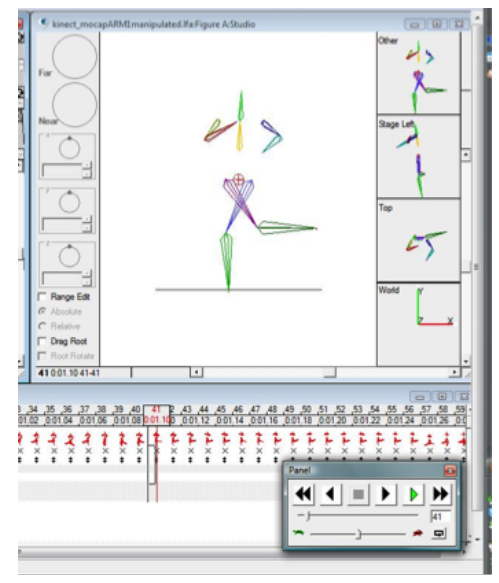
Figure 2. DanceForm’s Studio Interface